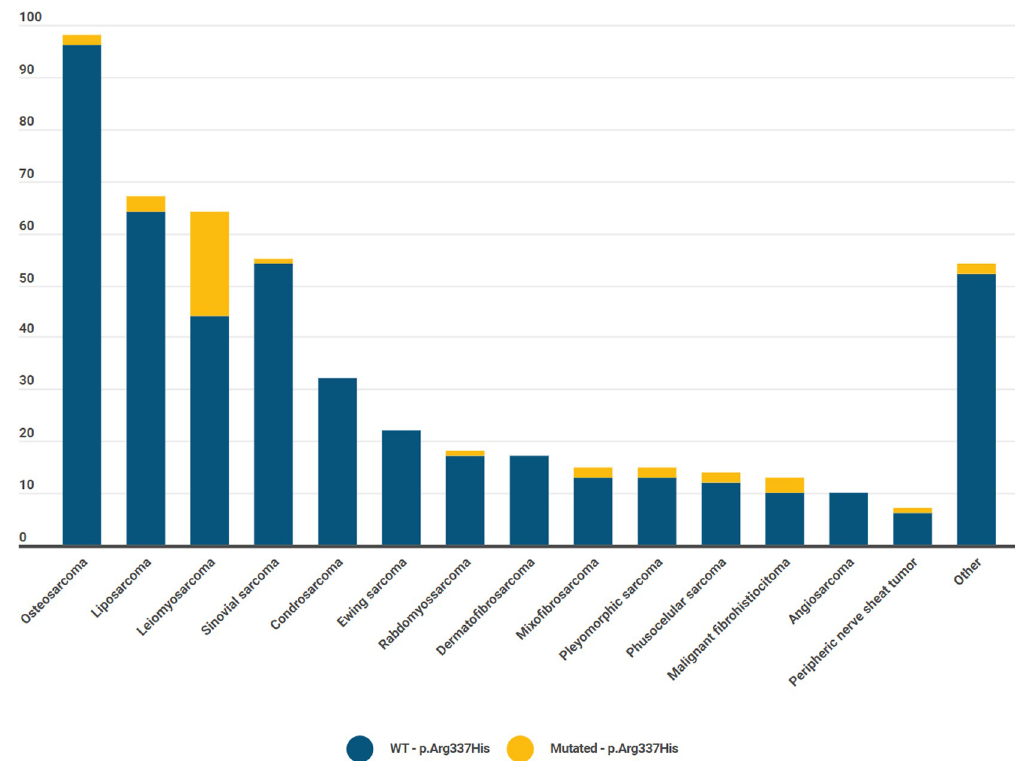
Fig 2. Mutational status according to sarcoma subtype.